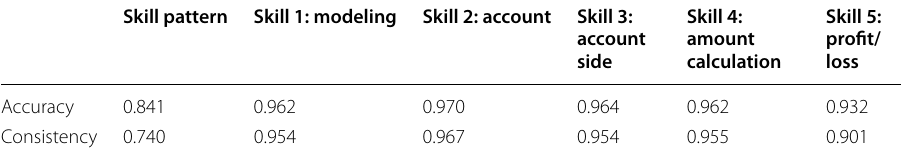
MLE values (Cui et al. 2012; Wang et al. 2015; George et al. 2019, p. 95): “Note. The first column gives the probability of classifying a randomly selected student consistently. The other rows contain the same measure, but focused on the classification of the selected student in only one